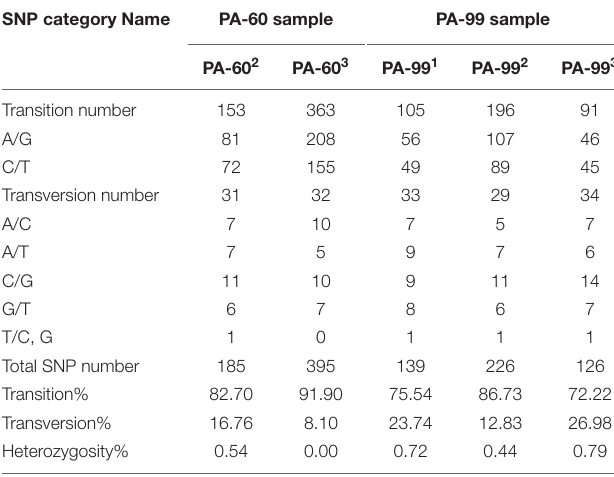
TABLE 1 | Statistical table of mutation sites and mutation category of